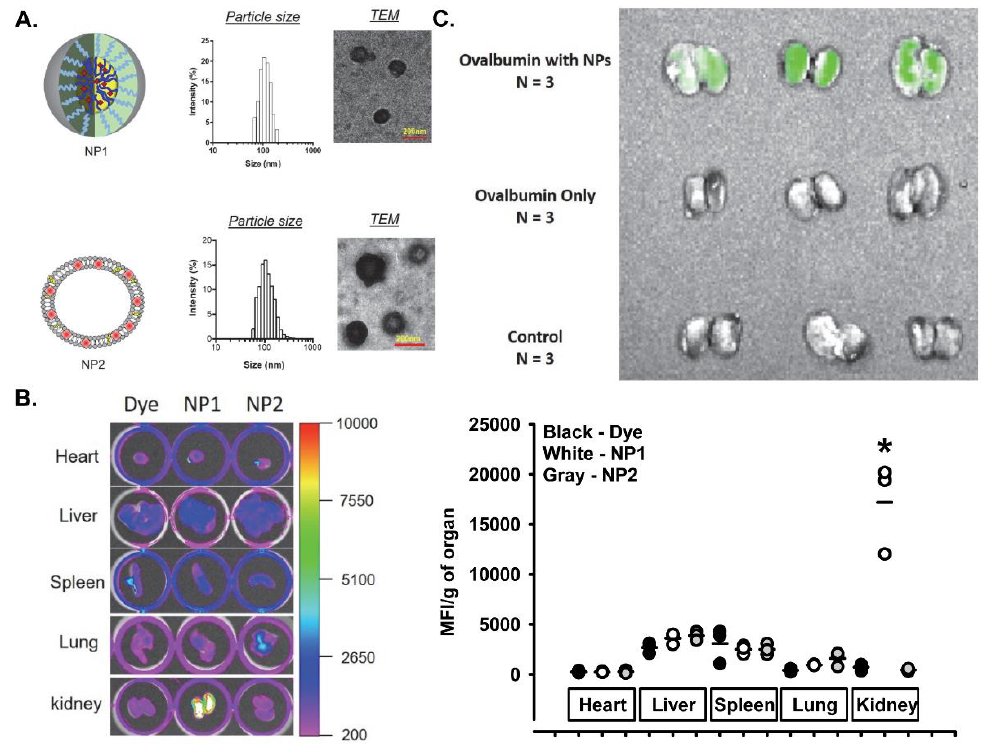
Figure 1. Characteristics of the nanoparticle and ability to target the kidney with dye and fluorescent protein. ( A ) Micellar and Liposome nanoparticles and their size. Scale bar = 200 nm. ( B ) Organs from mice 12 h after a single i.v. injection of Coumarin 6 dye alone, NP1 containing Coumarin 6 dye, or NP2 containing Coumarin 6 dye. Organs were imaged using an In Vivo FX Pro, and the mean fluorescence index (MFI) was calculated and expressed per gram of organ. ( C ) Kidneys from mice 12 h after a single i.v. injection of NP1 containing FITC-Ovalbumin, FITC-Ovalbumin alone, or vehicle alone. Organs were imaged using an In Vivo FX Pro. Results are expressed as dot plots and mean (n = 3 per group) and statistical analyses were performed with a one-way ANOVA followed by the Student–Newman–Keuls post hoc test. * p < 0.05 vs. Coumarin 6 dye alone group in the same organ.